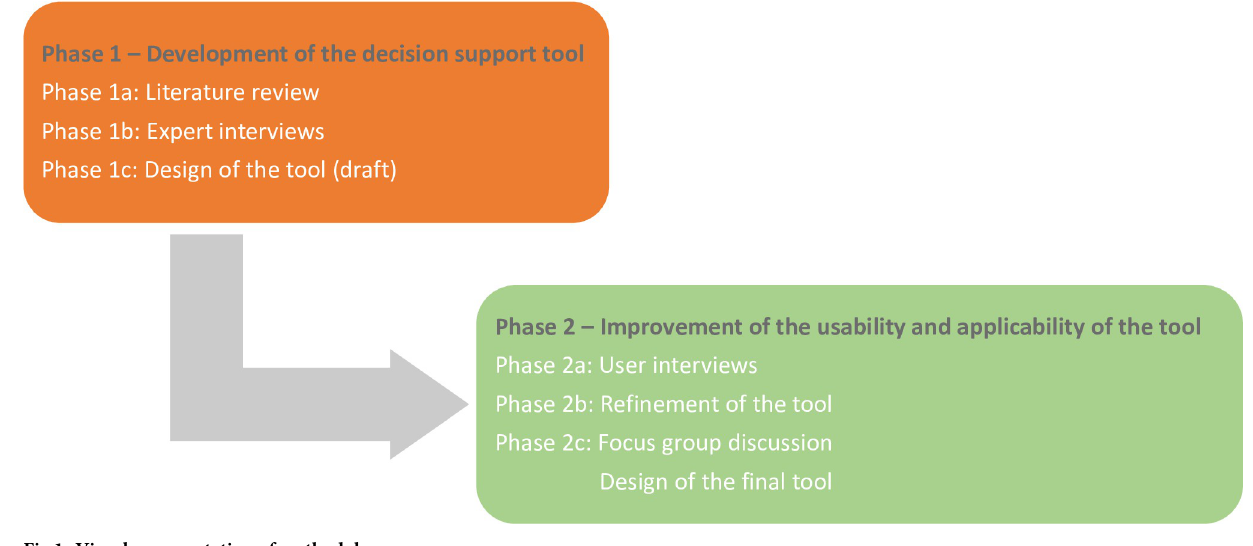
Fig 1. Visual representation of